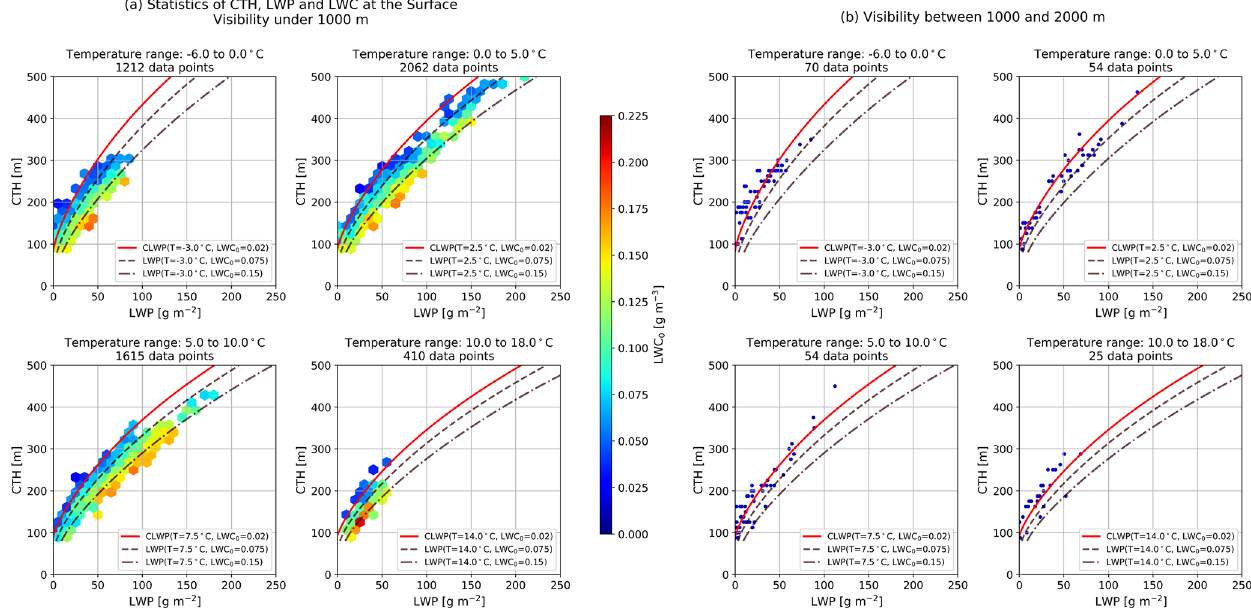
Figure 5. Observations of CTH, LWP, and LWC at the surface for different temperature and visibility ranges. Data associated with visibility values below 1000m are on the left ( a ), while data measured with visibility values between 1000 and 2000m are on the right ( b ). Conceptual model theoretical LWP and CLWP lines for different conditions, indicated in the legend, are superimposed. The adiabaticity values used in the conceptual model calculation are calculated using the adiabaticity parametrization of Sect. 4.2.